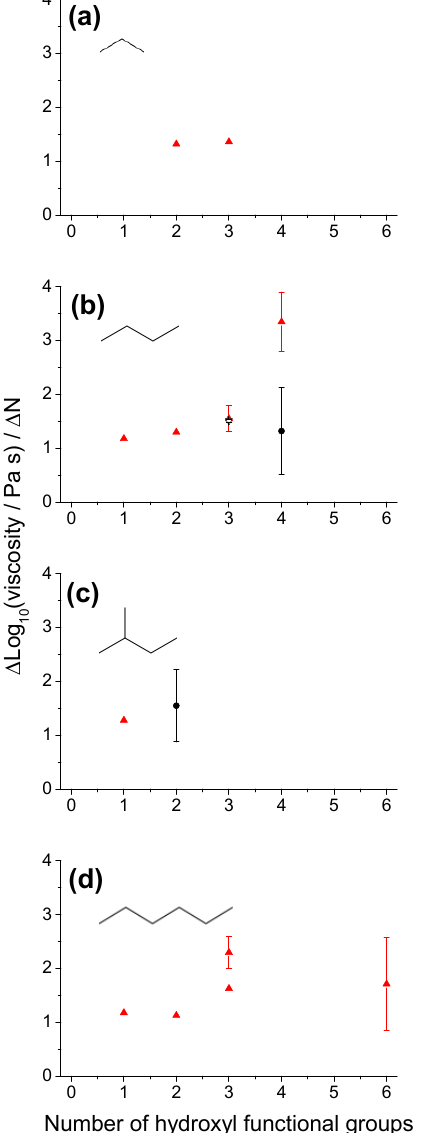
Figure 4. Plot of the change in log 10 (viscosity/Pas) per change in hydroxyl functional group ( (cid:49)N ) for compounds with (a) linear C 3 , (b) linear C 4 , (c) branched C 5 , and (d) linear C 6 carbon backbones. The values shown are as in Fig. 3, with experimental values deter- mined in this study shown in black, and literature values shown in red.